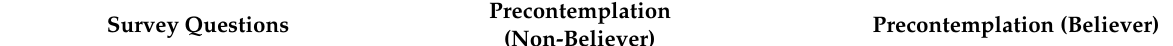
Table 3. ACP Behavioral Engagement of Older Indigenous Patients with Late-stage Cancers in Taiwan ( n =